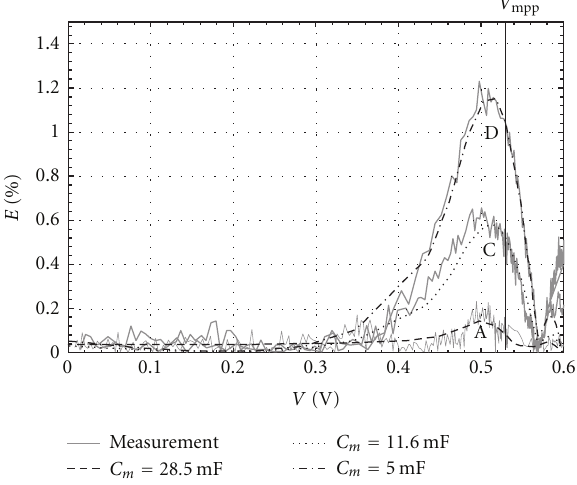
Figure 6: Voltage distribution of transient error for mc-Si cell.